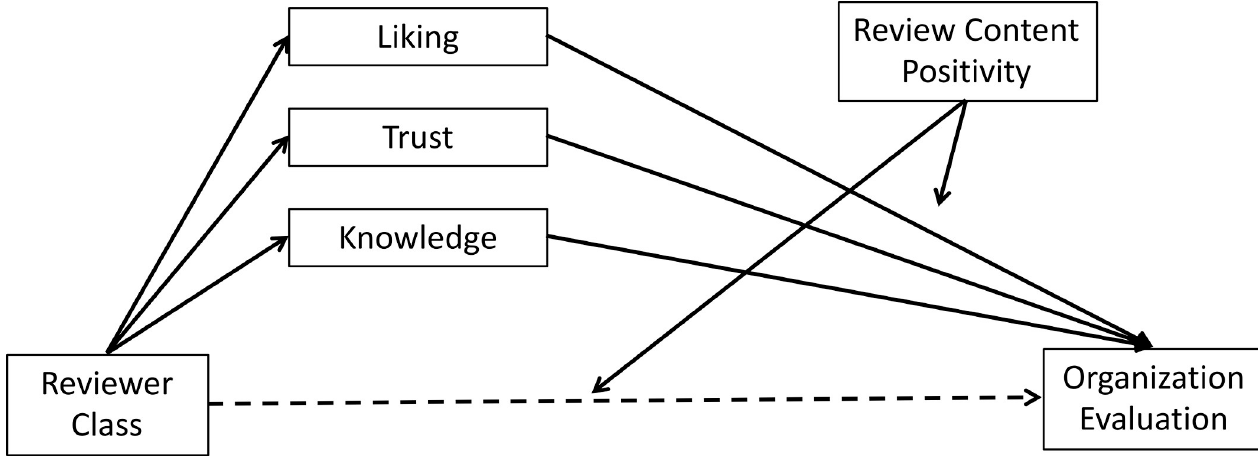
Fig 6. Schematic representation of the bootstrapping mediation analysis from Study 3, with Organization Status included as a covariate.